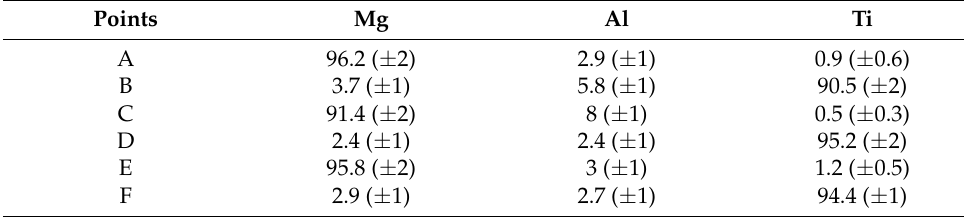
Table 4. Point EDS results around the interfaces